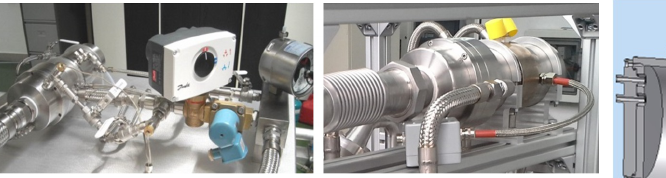
Figure 6: Numerical model used for rotor-dynamic calculations of the turbogenerator developed for the ORC cycle